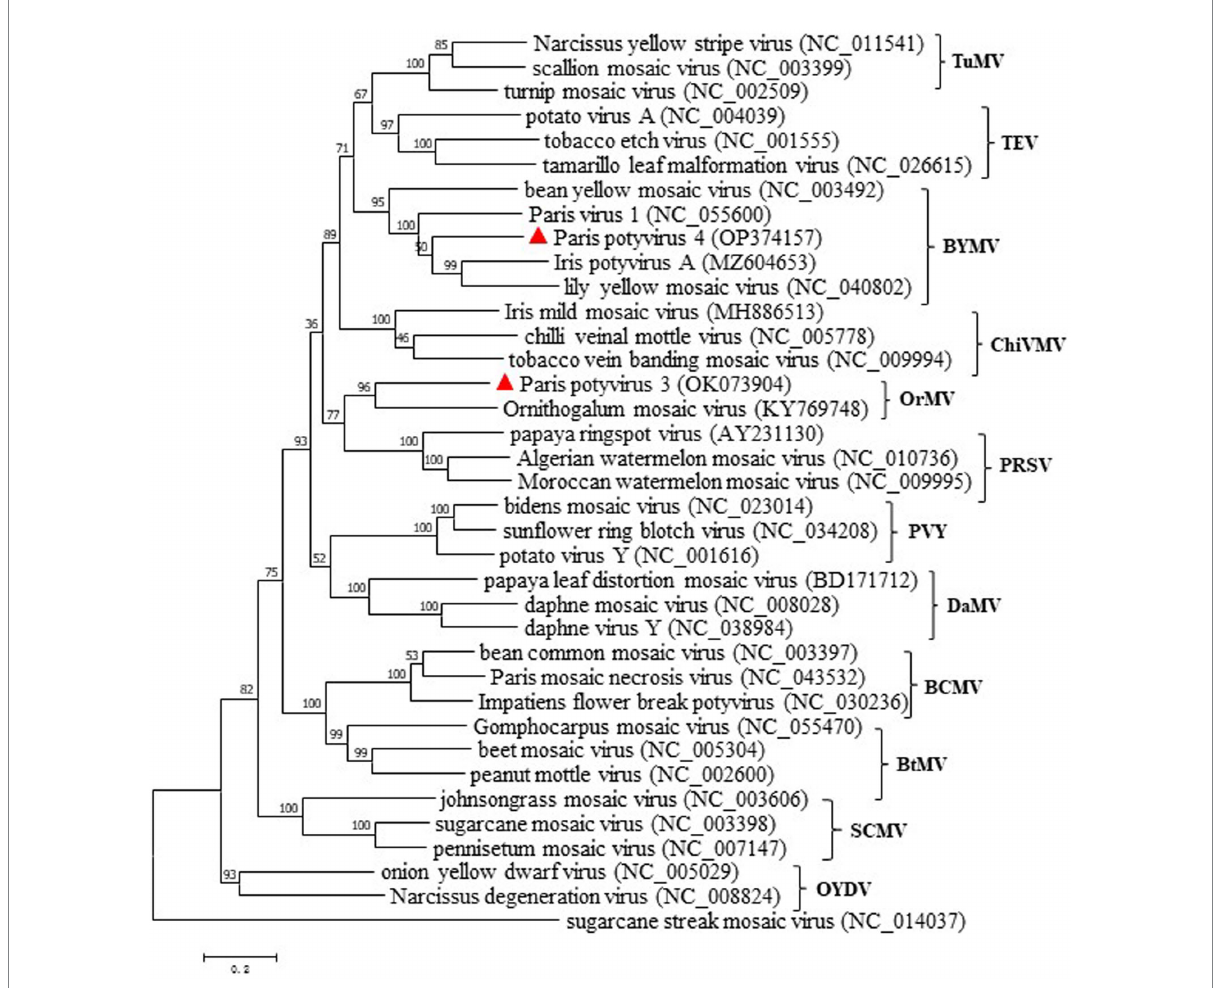
FIGURE. 4 Maximum-likelihood tree based on the deduced polyprotein sequences of ParPV-3, ParPV-4 and representative members of the genus Potyvirus . Each of the subgroups is indicated by abbreviation of the representative virus. Bootstrap analysis was applied using 1,000 bootstrap replicates. The scale bar representing a genetic distance of 0.2. Sugarcane streak mosaic virus, a member of the genus Poacevirus , was used as an